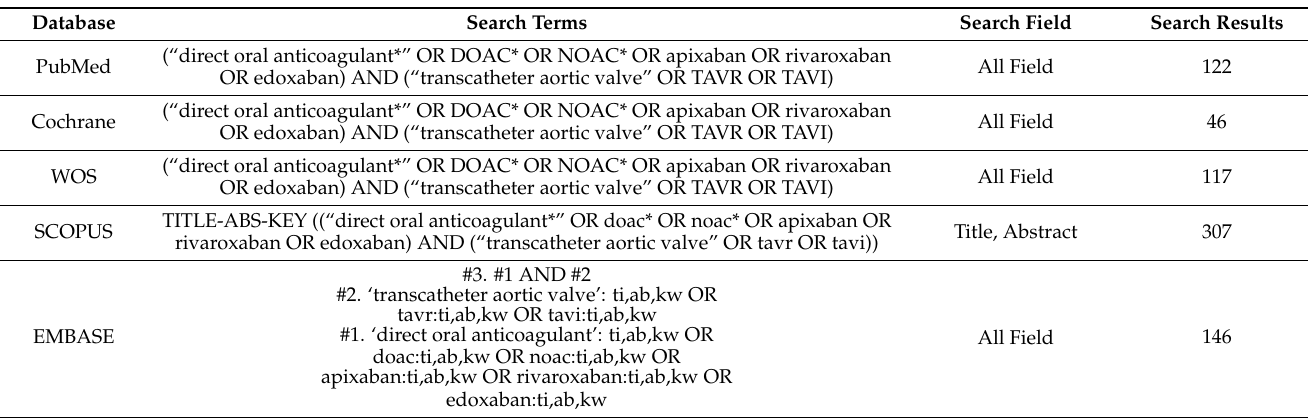
Table 1. Search terms and results in different